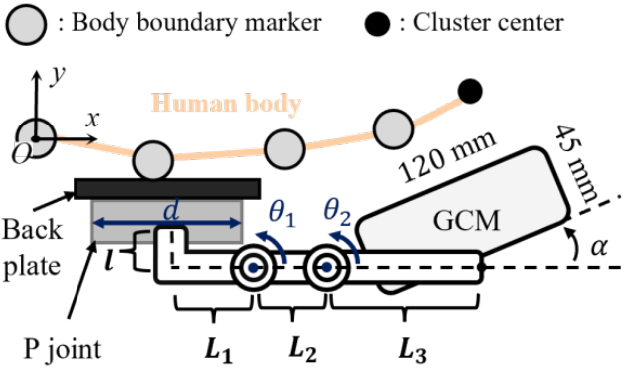
Figure 5. Kinematic model and design variables of prismatic – revolute – revolute (PRR) joint config- uration for optimization.